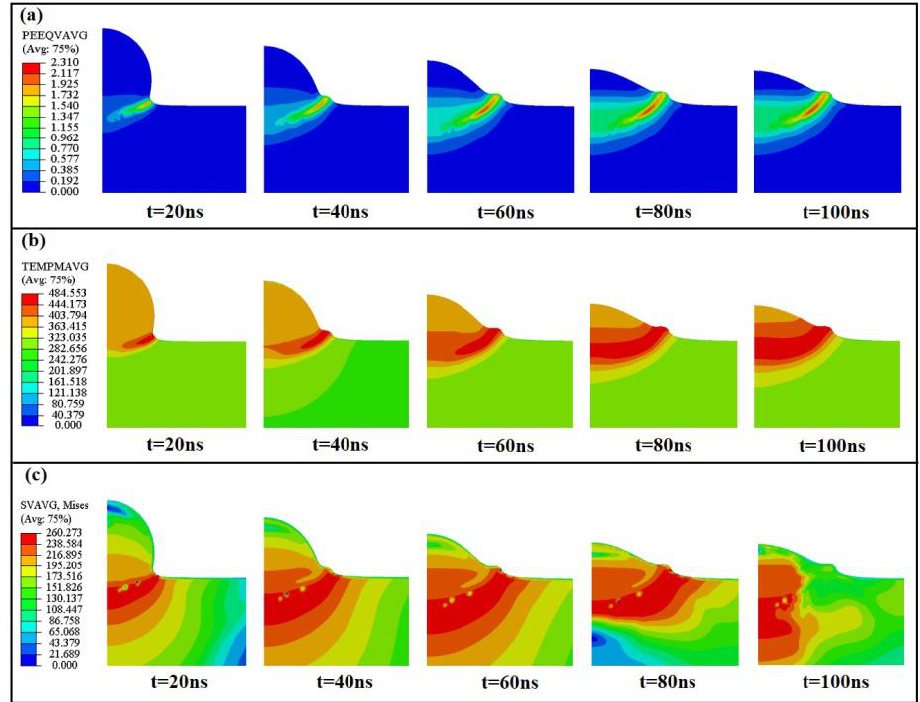
Figure 6. The simulation results show ( a ) the evolution of the equivalent plastic strain, ( b ) the evolution of the temperature and ( c ) the evolution of the stress.